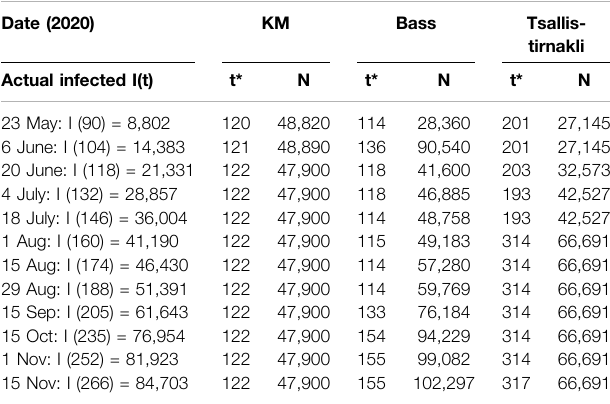
TABLE 2 | Bahrain results for KM, Tsallis-Tirnakli, and Bass models show Divergent size and duration